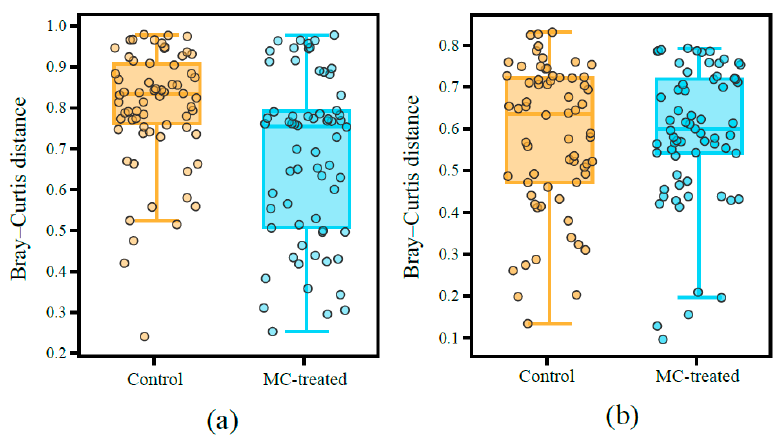
Figure 6. Box plot diagram of mean Bray–Curtis distance at OTU level between different times in the control and MC-treated pond: ( a ) phytoplankton, Welch’s t -test, p < 0.001; ( b ) bacteria, Welch’s t -test, p value = 0.29.